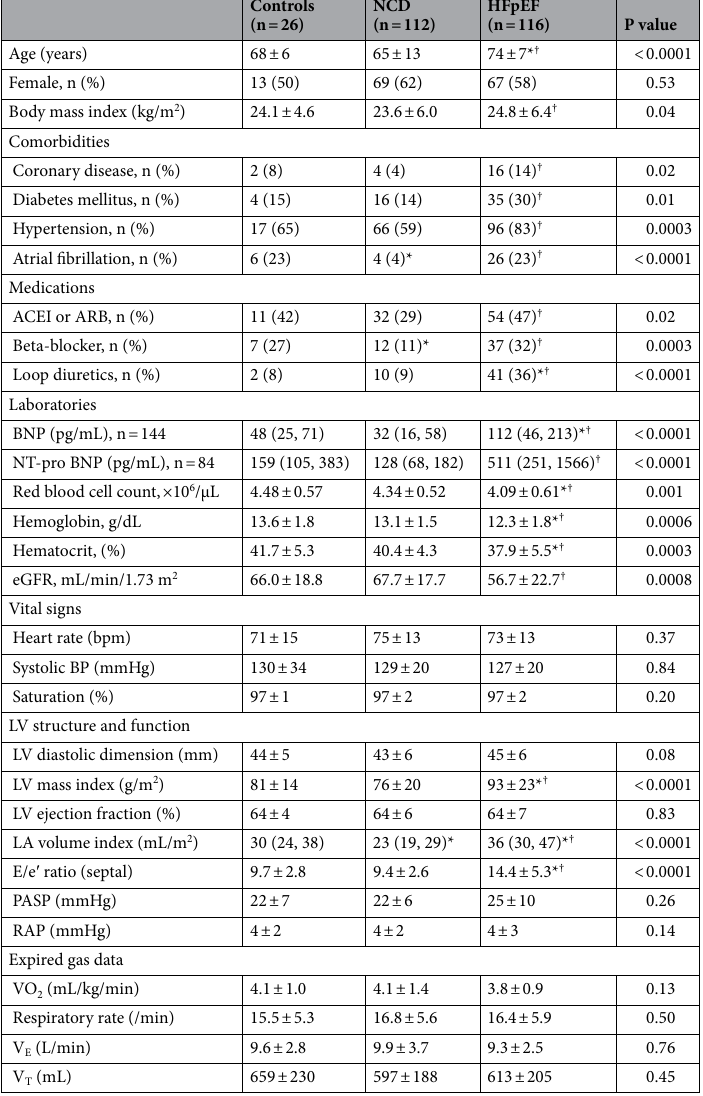
Table 1. Baseline characteristics. Data are mean ± SD, median (interquartile range), or n (%). Final column reflects overall group differences. *p < 0.05 vs. Controls; † p < 0.05 vs. NCD. ACEI, angiotensin-converting enzyme inhibitors; ARB, angiotensin-receptor blockers; BNP, B-type natriuretic peptide; BP, blood pressure; E/e ′ ratio, the ratio of early diastolic mitral inflow to mitral annular tissue velocities; eGFR, estimated glomerular filtration rate; HFpEF, heart failure with preserved ejection fraction; LA, left atrial; LV, left ventricular; NCD, non-cardiac dyspnea; NT-proBNP, N-terminal pro B-type natriuretic peptide; PASP, pulmonary artery systolic pressure; and RAP, right atrial pressure; VE , minute ventilation; VO 2 , oxygen consumption; V T, tidal